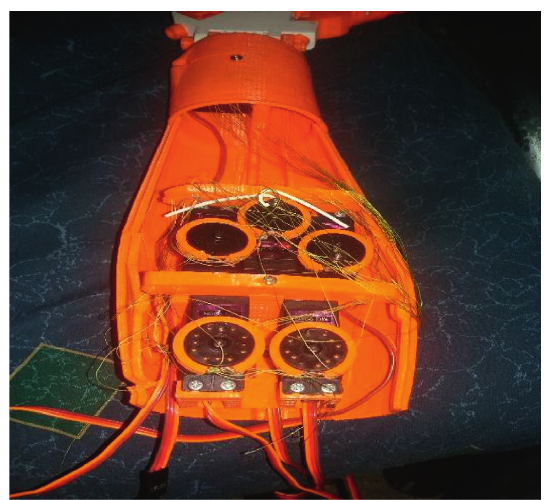
Figure 3: Lining and tensioning the hand.